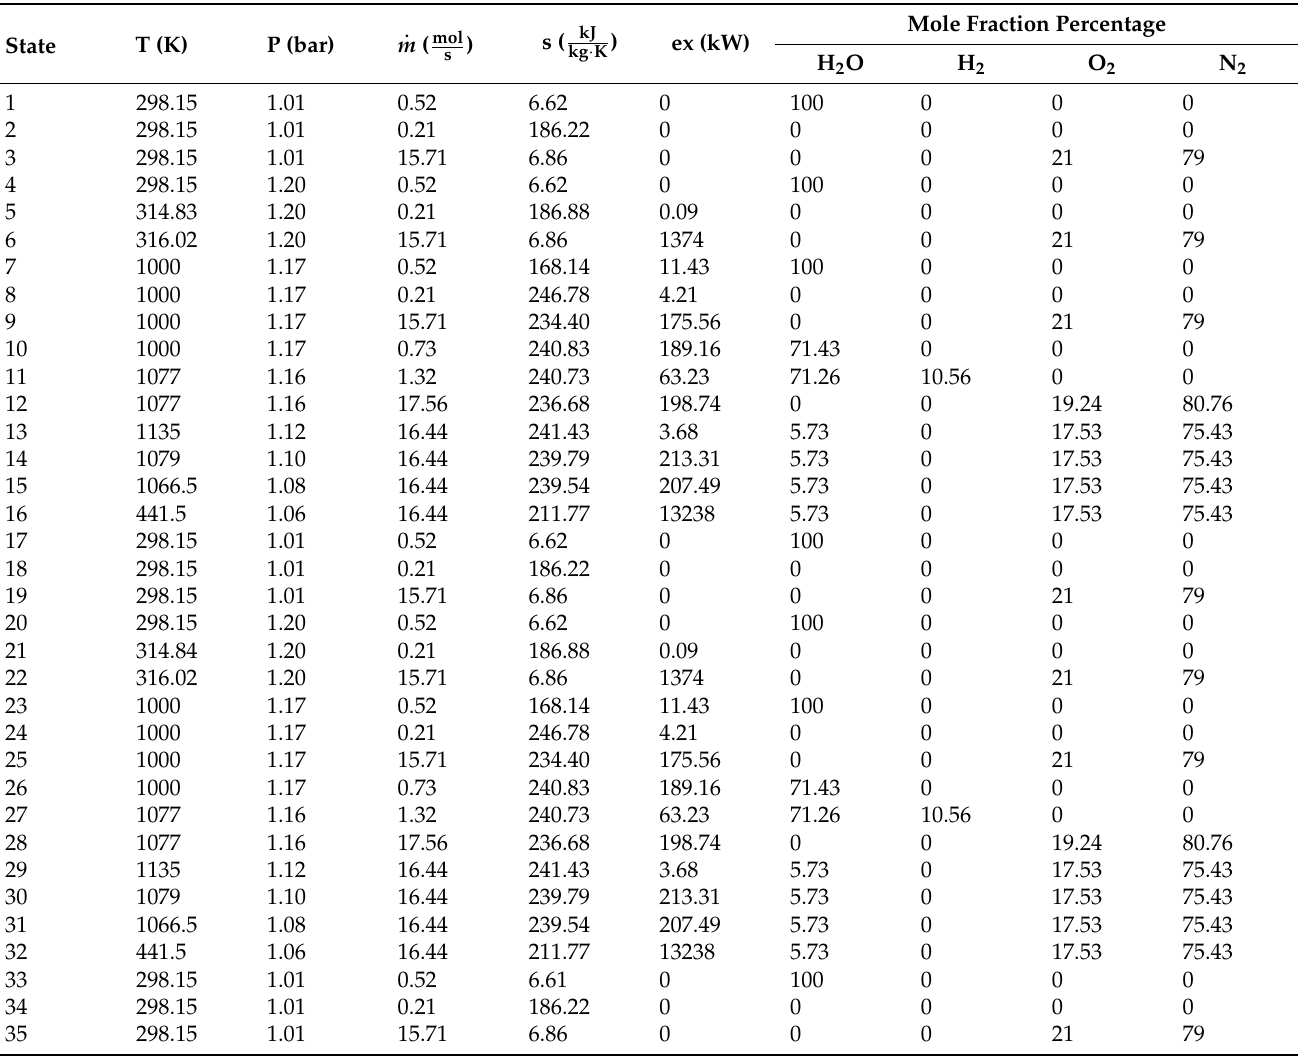
Table 3. The thermodynamic properties of the state variables of the SOFC stacks at 0.7 A/cm 2